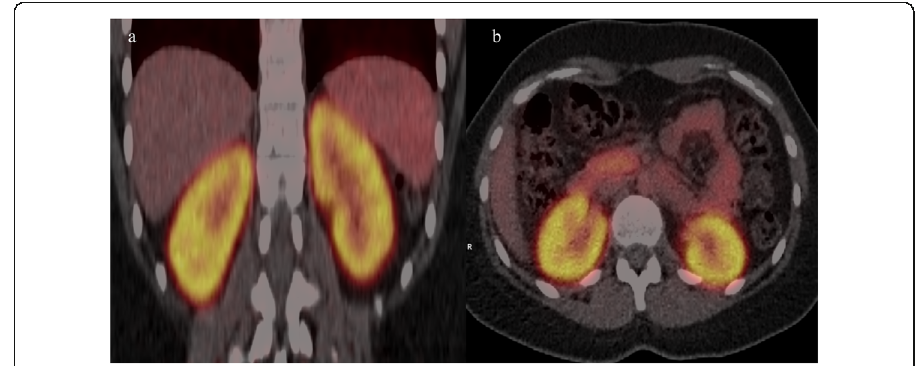
Fig. 9 Typical example of a coronal and b transaxial PET/CT images of kidneys during maximal 82 Rb